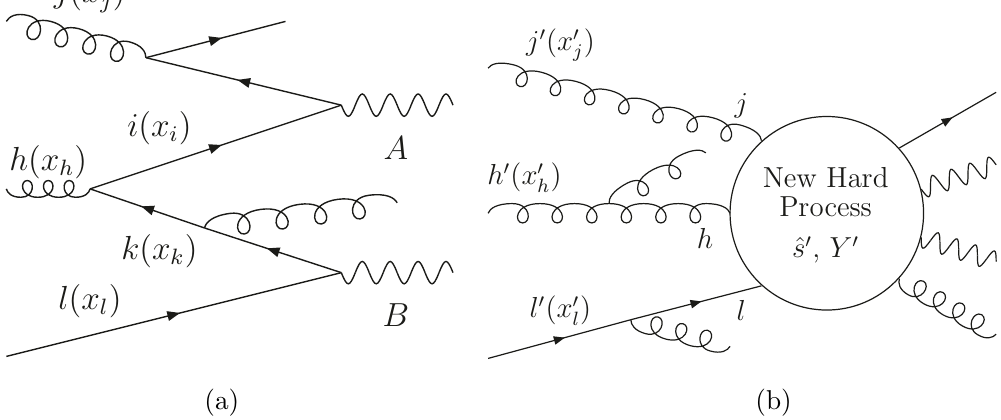
Figure 5 . Sketch of the merging phase. In (a), Q 2 = (cid:22) 2 A new hard process initiated by partons h , j and l is de(cid:12)ned. In (b), Q 2 = Q 2 partons extracted from the beams are now h 0 , j 0 and l 0